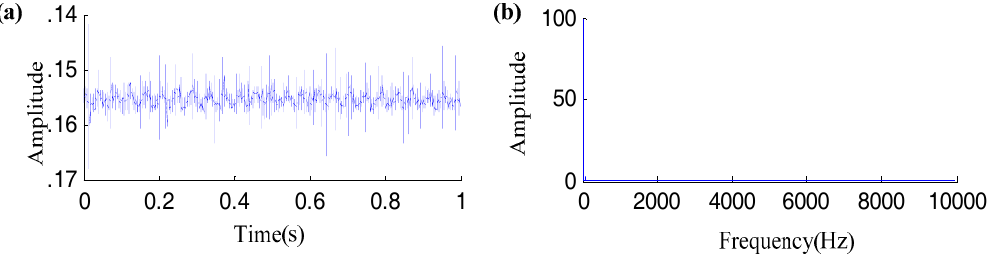
Figure 10. Time domain waveform and Hilbert envelope demodulation spectrum of the collected vibration signal with noise and resonance interference. (a) The waveform of the collected vibration signal in the time-domain. (b) The Hilbert envelope demodulation spectrum of the collected vibration signal.